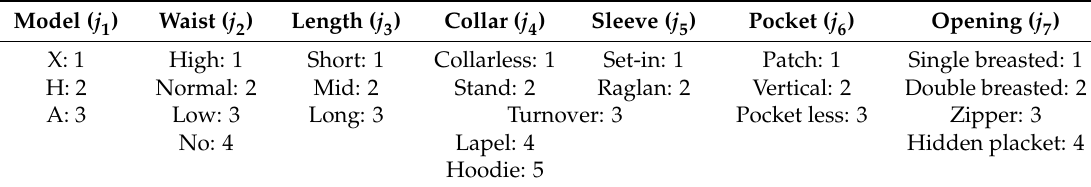
Table 2. Female coat design elements.